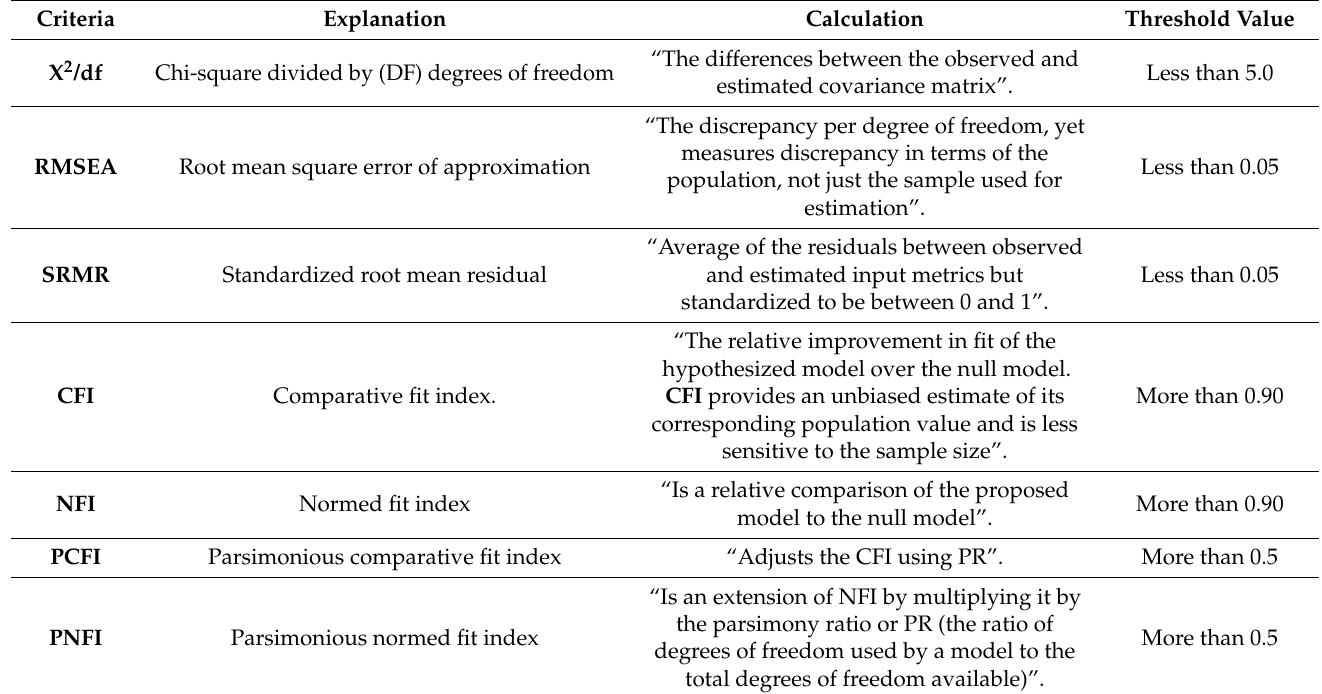
Table 2. SEM GoF